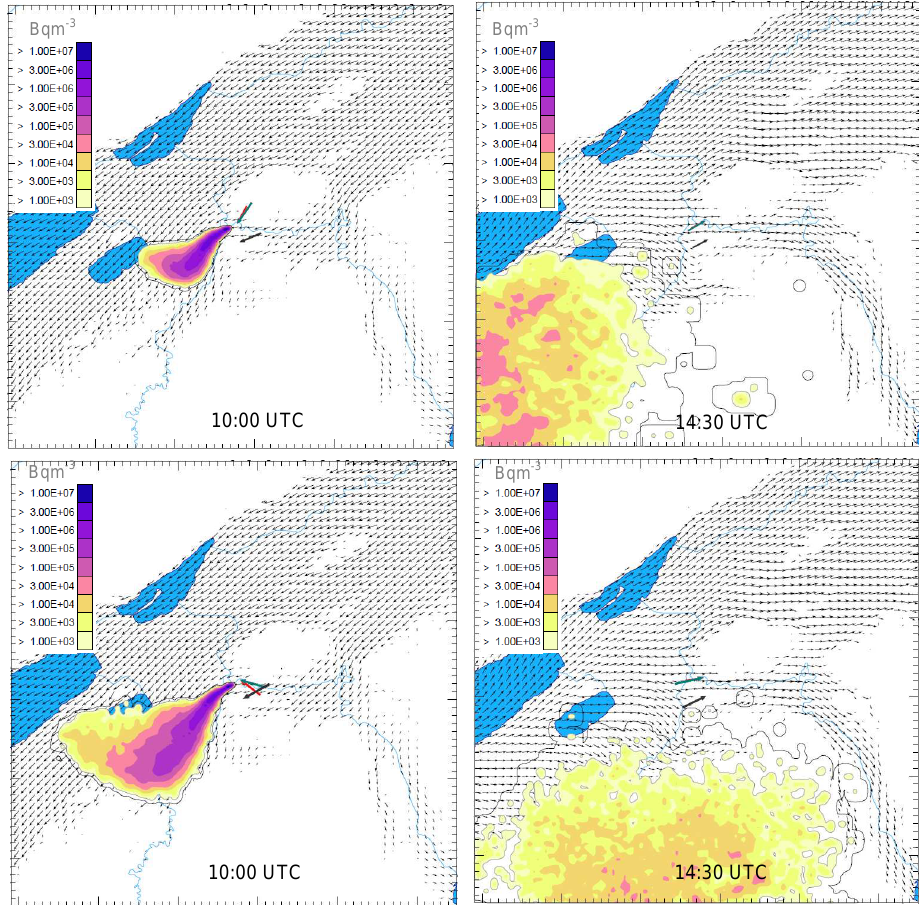
Fig. 9. Concentration levels of a virtual radioactive plume emitted at the Muehleberg nuclear power plant and wind fields based on COSMO-2 forecasts. The radioactive plume is calculated at surface level (1.5ma.g.l.). Top row: dispersion predicted based on meteo- rological model forecasts, bottom row: dispersion simulated based on measured meteorology. Red arrow: winds at 10ma.g.l., blue arrow: winds at 110ma.g.l., black arrow: winds at 70m on a nearby hill 450m above the power plant site; plume release at 09:00hUTC. The blue surfaces are lakes. Note that the arrows of the wind field and those of the wind observations are not to the same